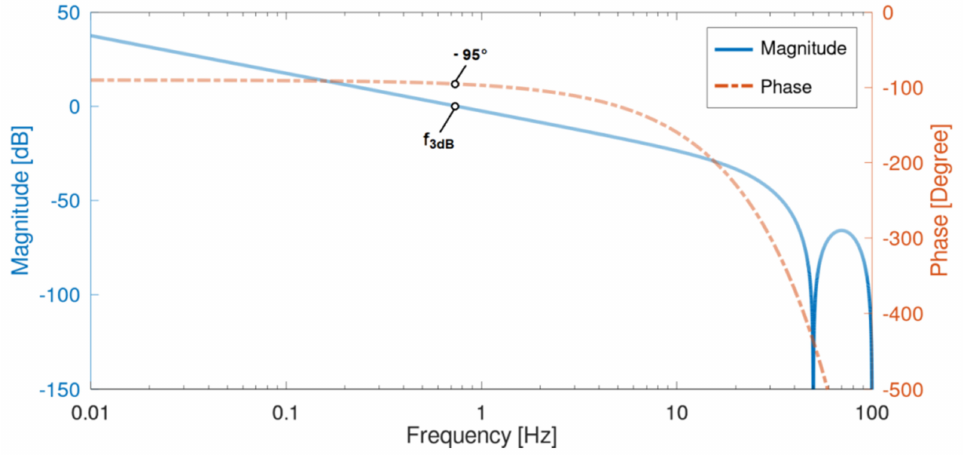
Figure 4. Magnitude and phase response of LG ( z ) for F s = 2 kHz, V r = 200 LSB, and k i = 2 − 23